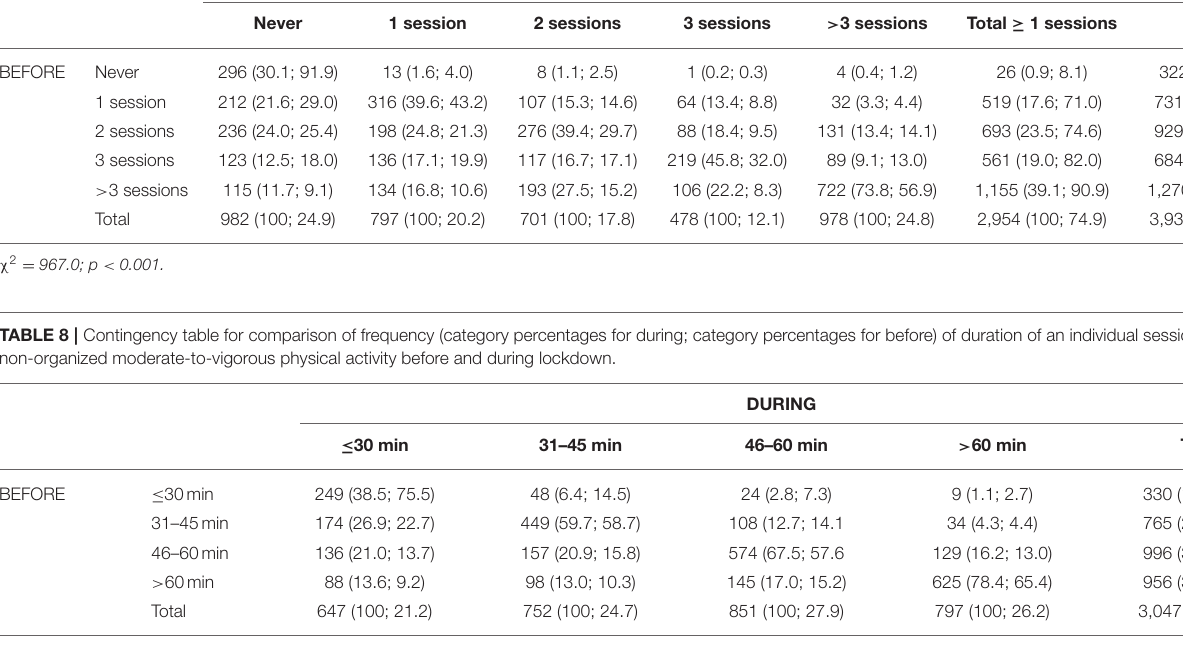
TABLE 7 | Contingency table for comparison of frequency (category percentages for during; category percentages for before) of participation in non-organized moderate-to-vigorous physical activity before and during lockdown. DURING Never 1 session